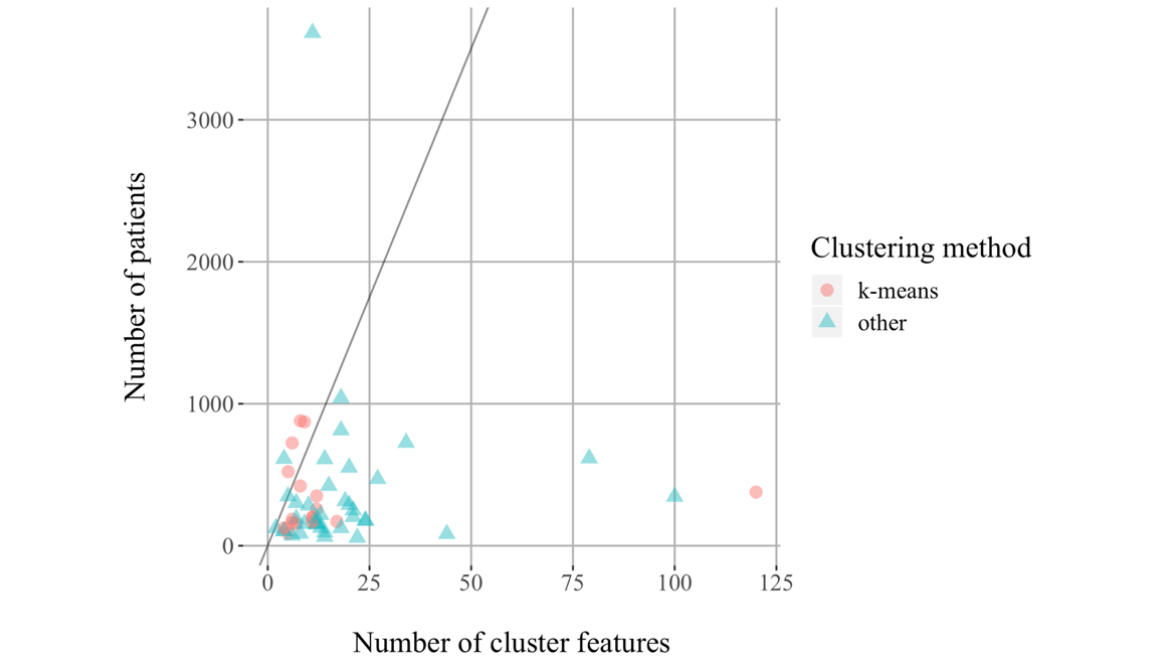
Figure 3. Number of patients versus final number of cluster features. The line corresponds to the number of patients that is equal to 70 times the number of